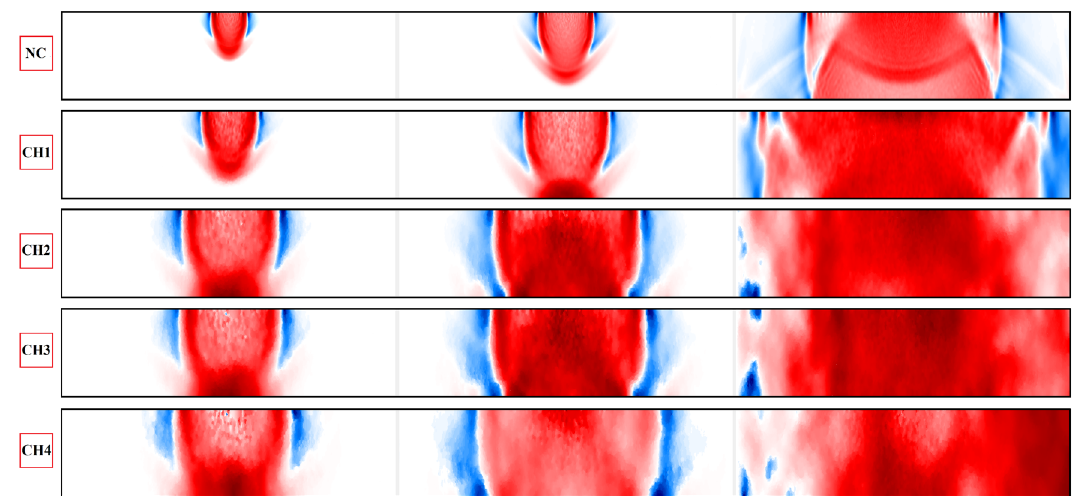
5 10 (s)) and different − ×